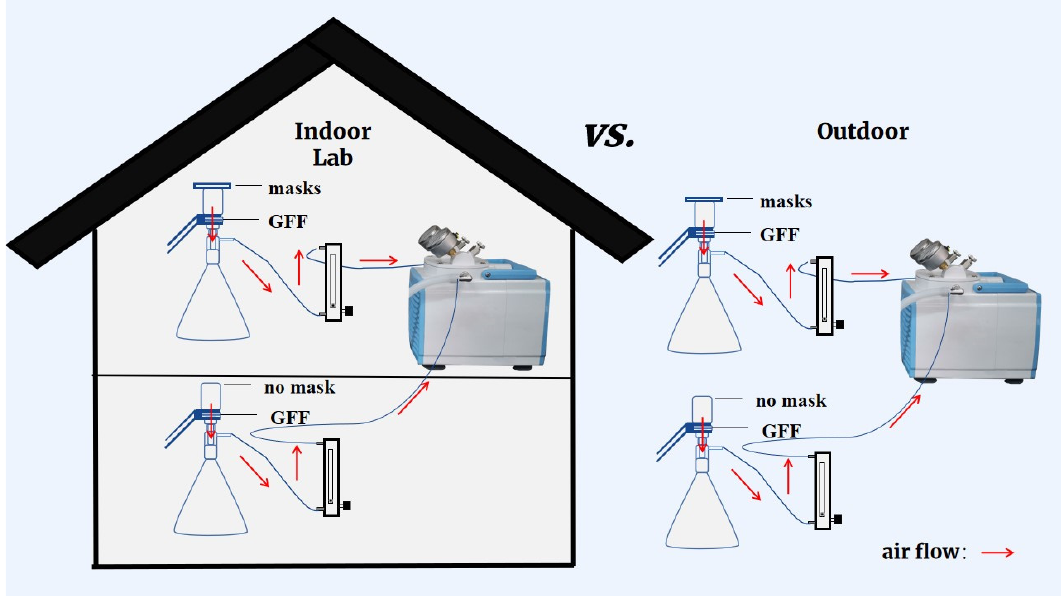
Figure 1. Diagram explaining multiple experimental scenarios for wearing different kinds of masks in indoor or outdoor environments.